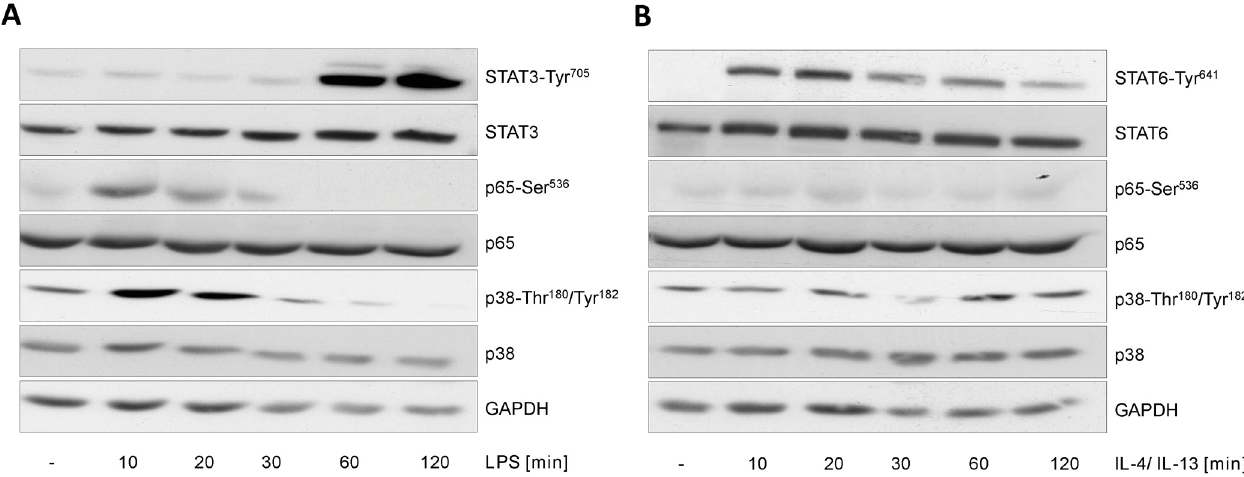
Fig 6. Transcription factor activity in macrophages under M1 (+LPS) or M2 (+IL-4/IL-13) stimulating conditions. Primary murine BMDMs were stimulated with (A) LPS (50 ng/ml) or (B) IL-4/IL-13 (25 ng/ml each) for the times indicated and whole cellular protein extracts were prepared. 30 μ g of protein/lane were subjected to immunoblot analysis using antibodies specific for (A) STAT3-Tyr 705 , STAT3, p65-Ser 536 , p65, p38-Thr 180 / Tyr 182 , p38 or for (B) STAT6-Tyr 641 , STAT6, p65-Ser 536 , p65, p38-Thr 180 /Tyr 182 , p38 and GAPDH for loading control. Representative data for at least three independent experiments are shown.